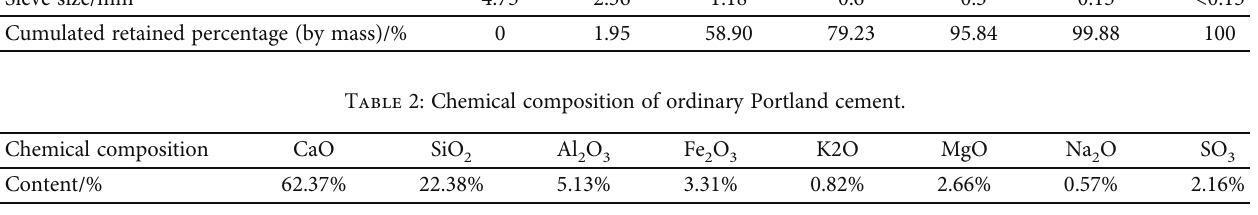
Table 3: The physical and mechanical properties of cement. Setting